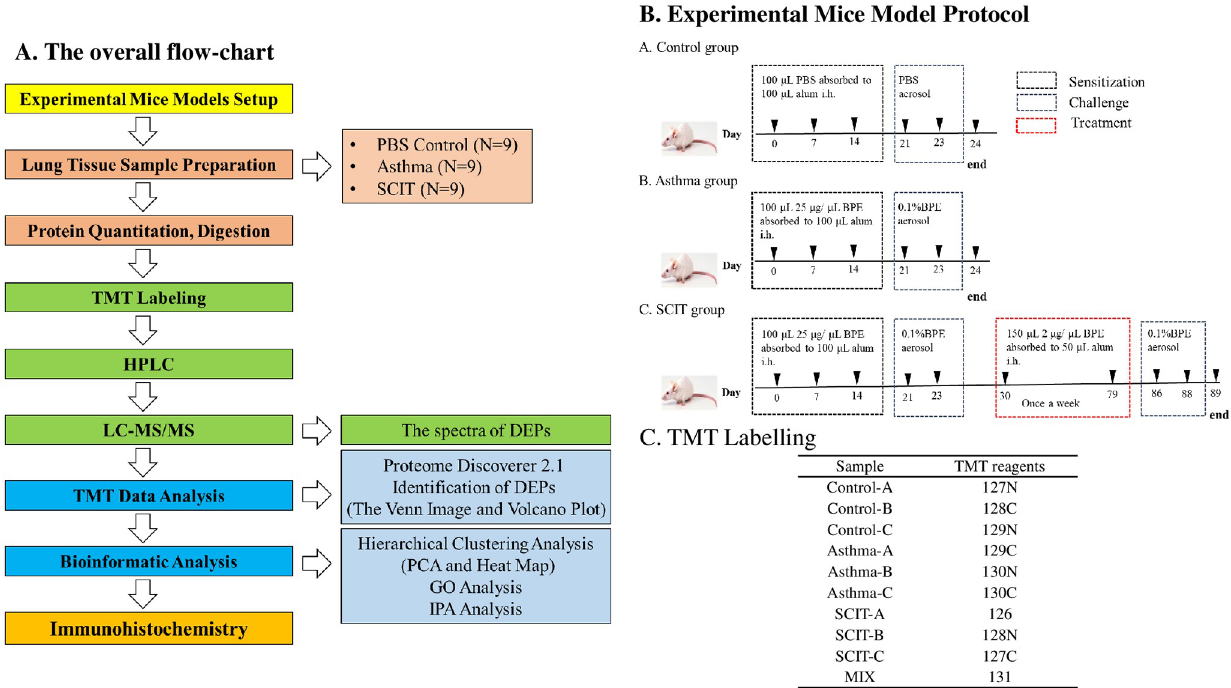
Fig 1. Study design. A. The overall flow-chart. B. Experimental mice model protocol. (1). The control group: The mice were primary sensitized with 100 μ L (25 μ g/ μ L) phosphate buffered saline (PBS) mixed with 100 μ L alum (Imject Alum, Thermo, USA) by subcutaneous injection on days 0, 7 and 14. The mice received nebulized PBS in PBS 3 times for 30 min on days 21–23. On day 24, the mice were sacrificed for sample preparation. (2). The asthma group: The mice were primary sensitized with 100 μ L (25 μ g/ μ L) birch pollen extract (BPE) mixed with 100 μ L alum (Imject Alum, Thermo, USA) by subcutaneous injection on days 0, 7 and 14. The mice received nebulized 0.1% BPE in PBS 3 times for 30 min on days 21–23. On day 24, the mice were sacrificed for sample preparation. (3). The SCIT group. C. TMT labelling: TMT-127N, TMT-128C, and TMT-129N were used for the PBS control group sample pools; TMT-129C, TMT-130N, and TMT-130C were used for the asthma group sample pools and TMT-126, TMT-128N, and TMT-127C were used for the SCIT group sample